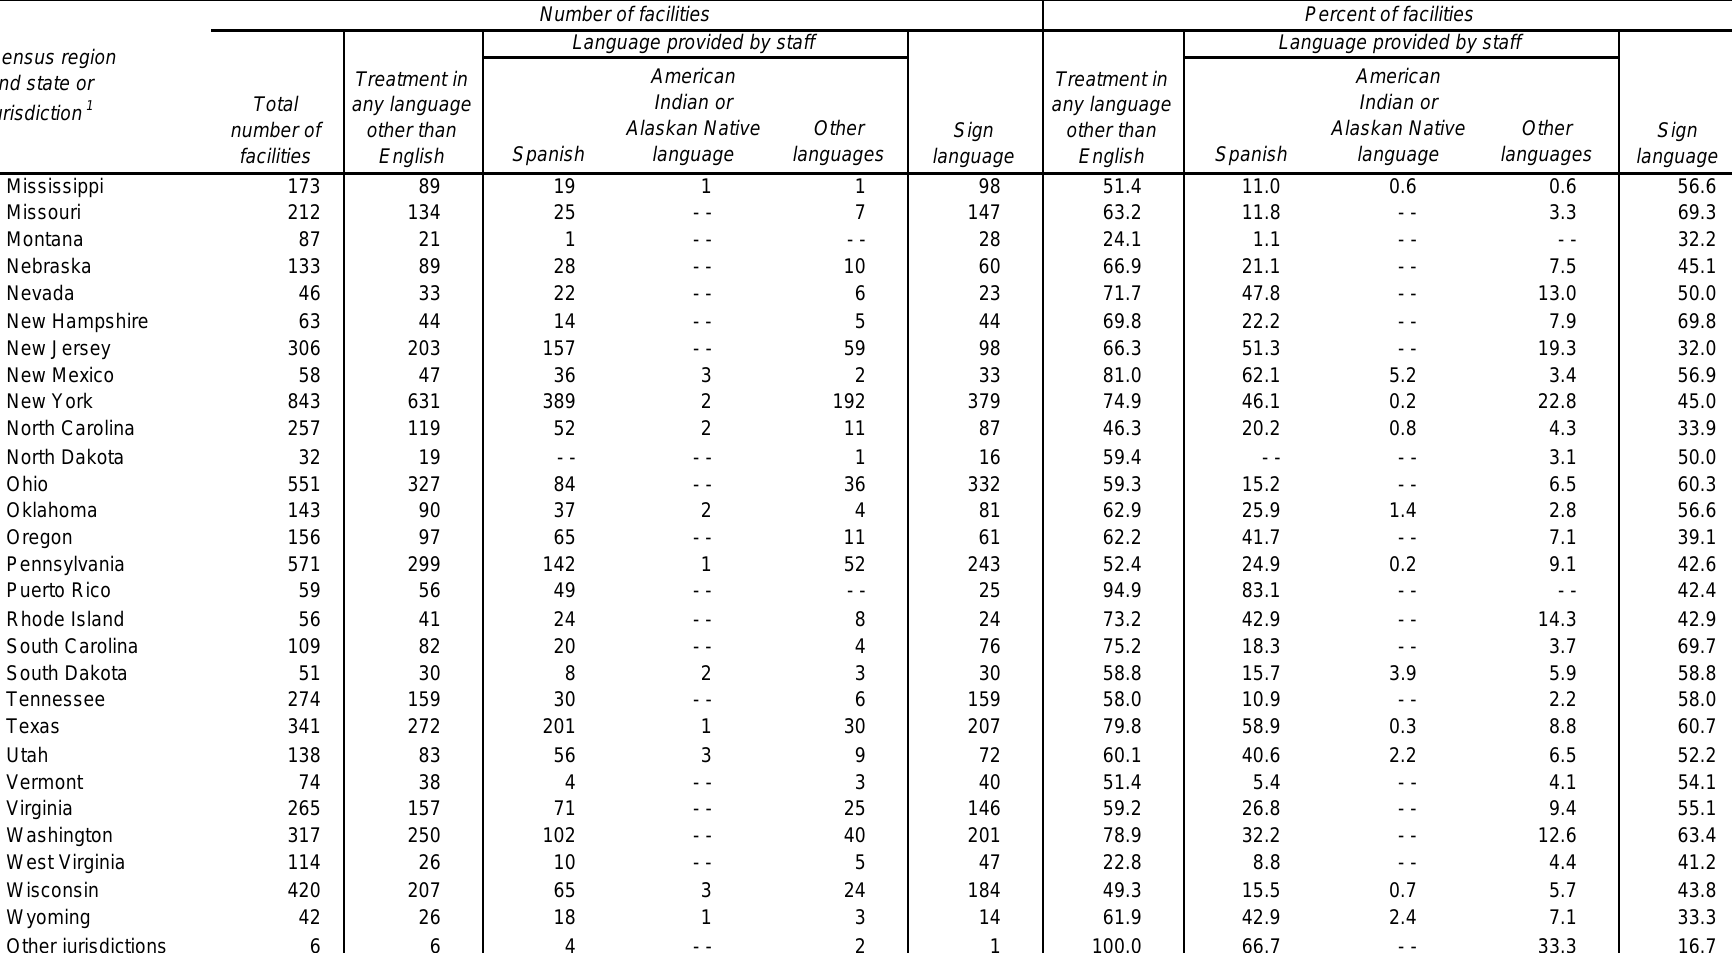
Table 3.11. Mental health treatment facilities offering treatment services in a language other than English and in sign language for the deaf and hard-of-hearing, by Census region and state or jurisdiction: Number and percent, 2017